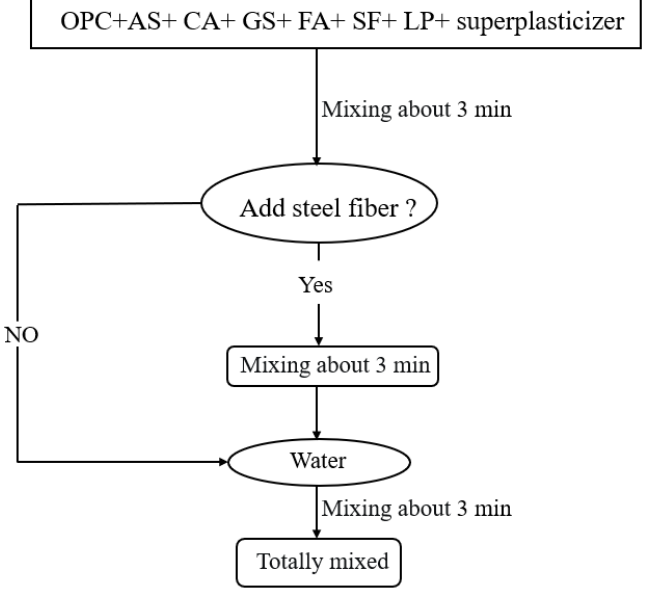
Table 4. Main performance indicators of steel fibers.